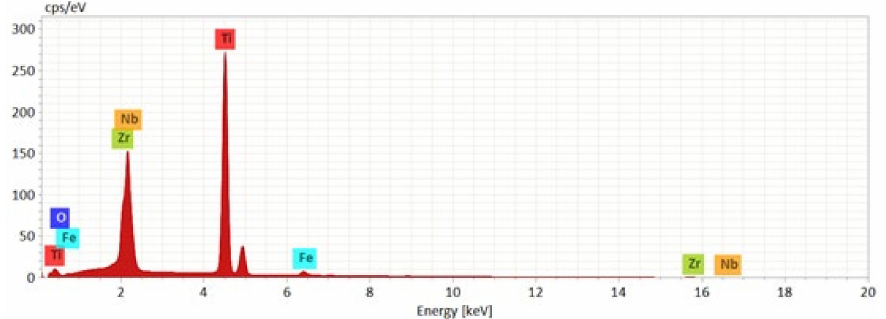
Figure 2. EDS spectrum for the sample Ti29.3Nb13.6Zr1.9Fe in cast state.